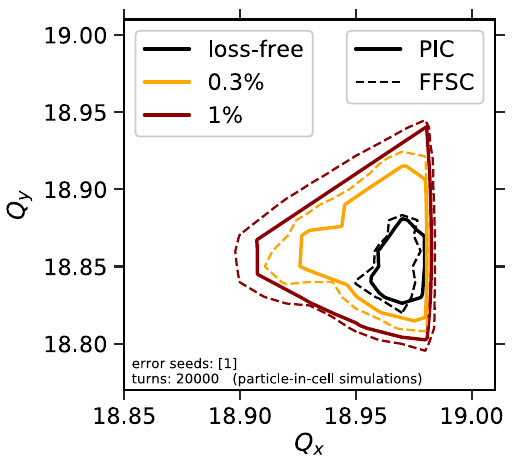
FIG. 10. Comparison of predicted loss contours for PIC and FFSC